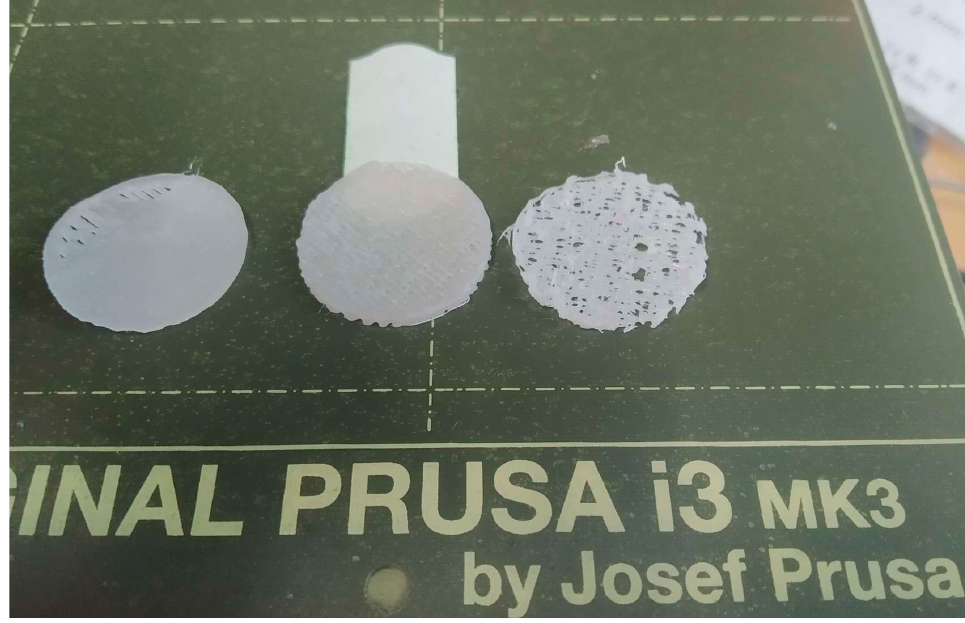
Figure 6. 3D printed samples of pure PCL ( left ), PCL 20 ( middle ) and PCL 40 ( right ).